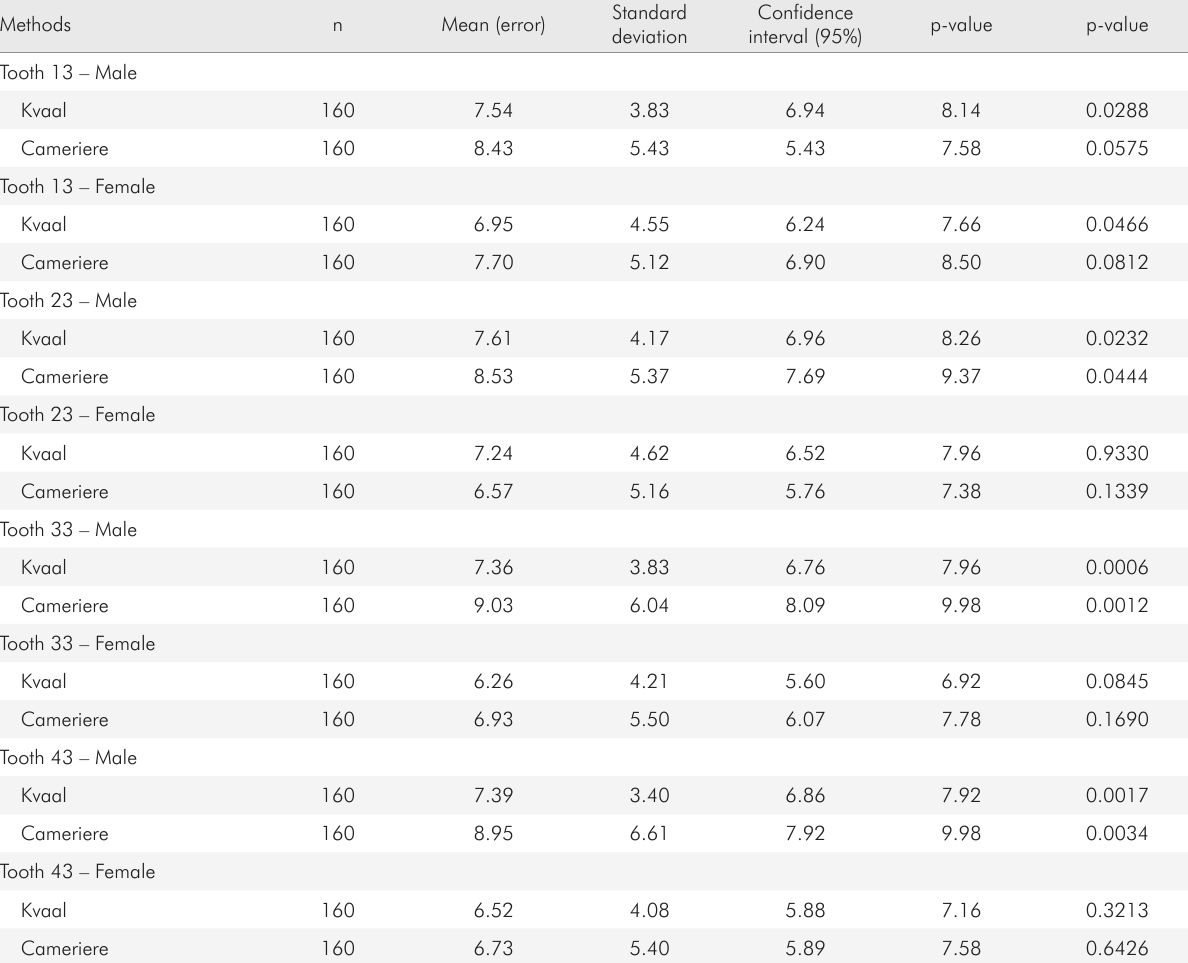
Table 5. Comparison of the results obtained for the Kvaal and Cameriere methods as per sex.